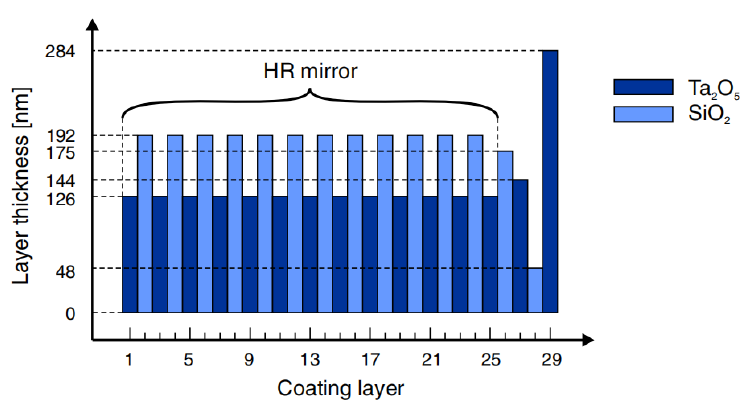
Figure 13. Schematic diagram of the reflection grating structure.